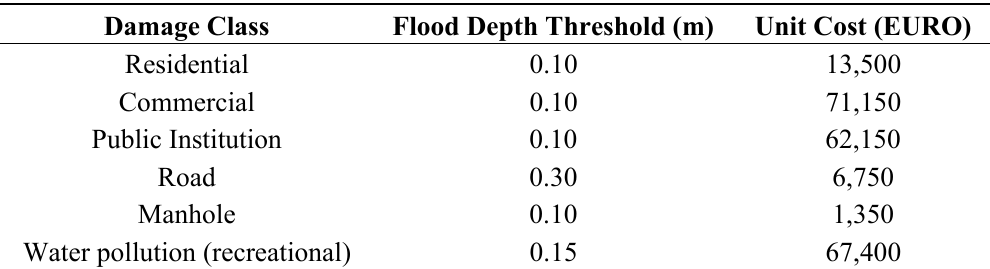
Figure 3. Vulnerability of the urban area in the city of Odense to the hazard illustrated in Figure 2. Table 1. Overview of the damage classes and unit costs used in the flood risk assessment framework. The unit cost is incurred if (some part) of the damage class is exposed to a flood depth higher than the threshold